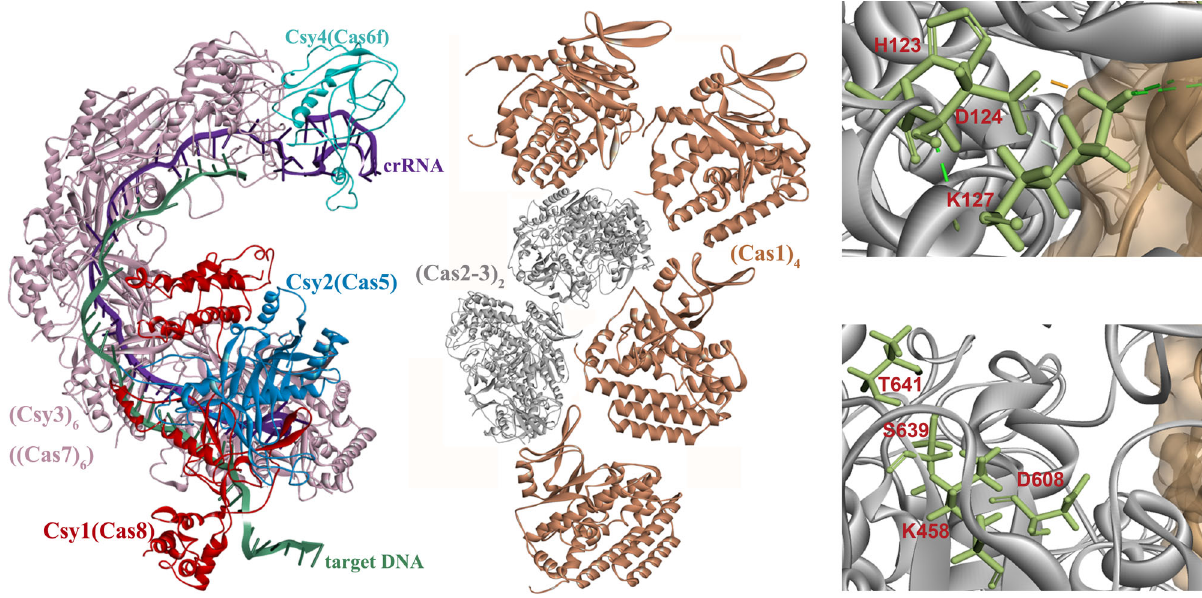
Fig. 5 Simulated structure diagram of Type I-F CRISPR/Cas complex. Left panel: Model protein structures of six proteins (Cas1, Cas2-3, Csy1, Csy2, Csy3 and Csy4) in CRISPR/Cas complex. Right panel: Location of mutation sites (H123, D124, K127, K458, D608, S639, and T641; red font) in